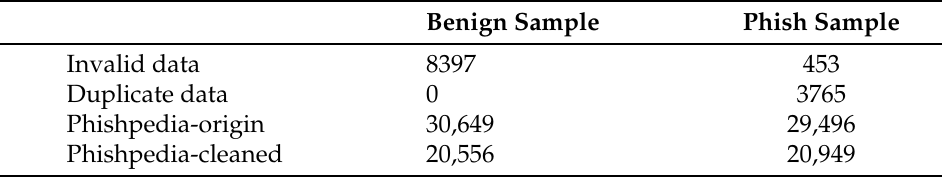
Table 3. Details of the used data